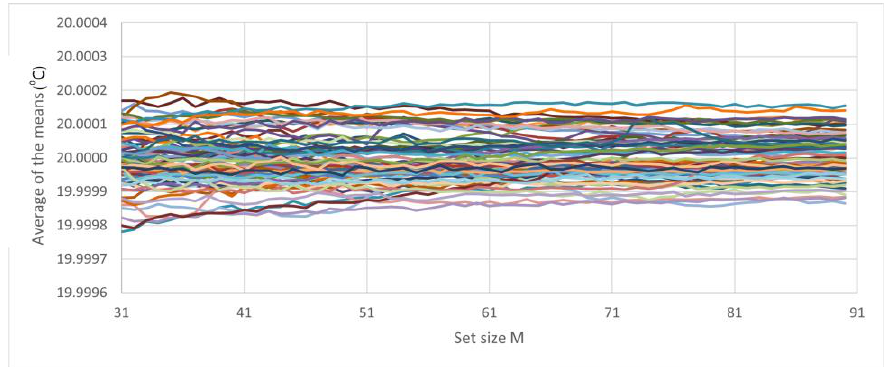
Figure 12. Measurements of the classes of sets of 100 elements, where each element is the average of 10 measurements, starting from M = 31.